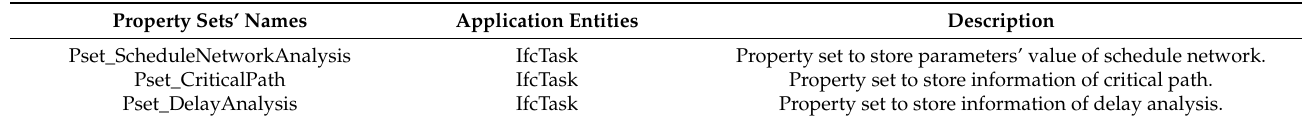
Table 3. Definition of the delay analysis property set.